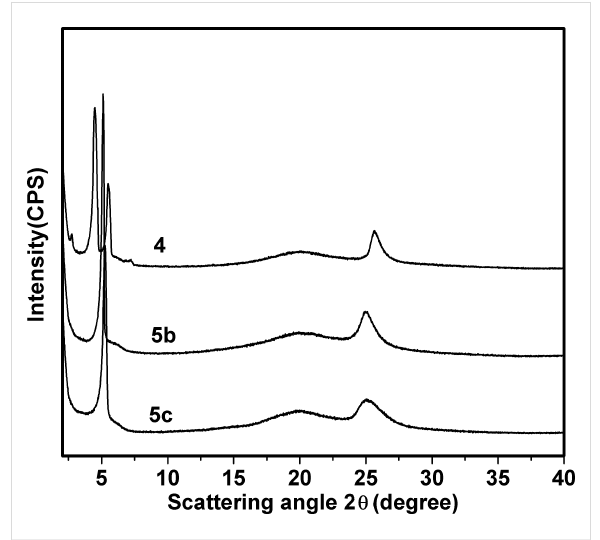
Figure 4: Powder X-ray diffraction patterns of the DLC trimmers 4 , 5b and 5c at room temperature.